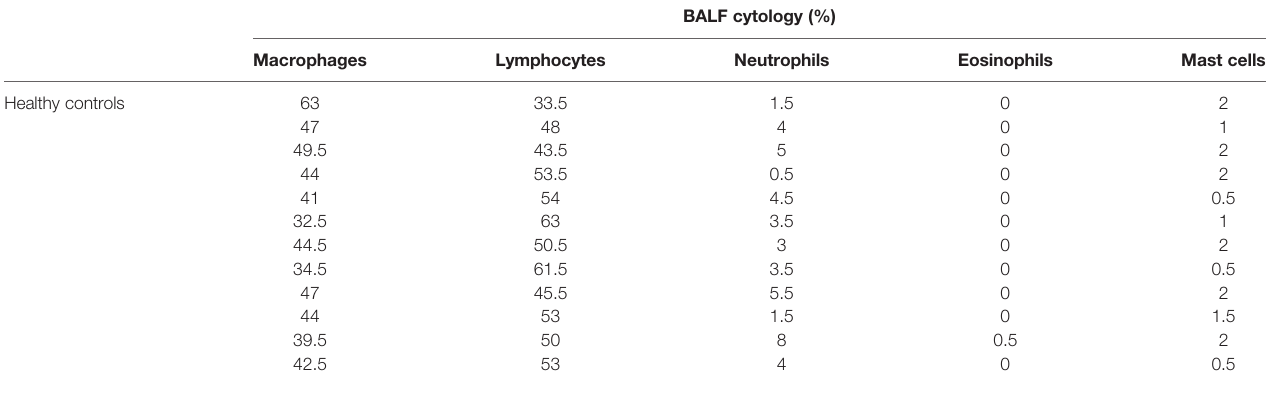
TABLE 1 | Cytology fi ndings of healthy horses enrolled in this